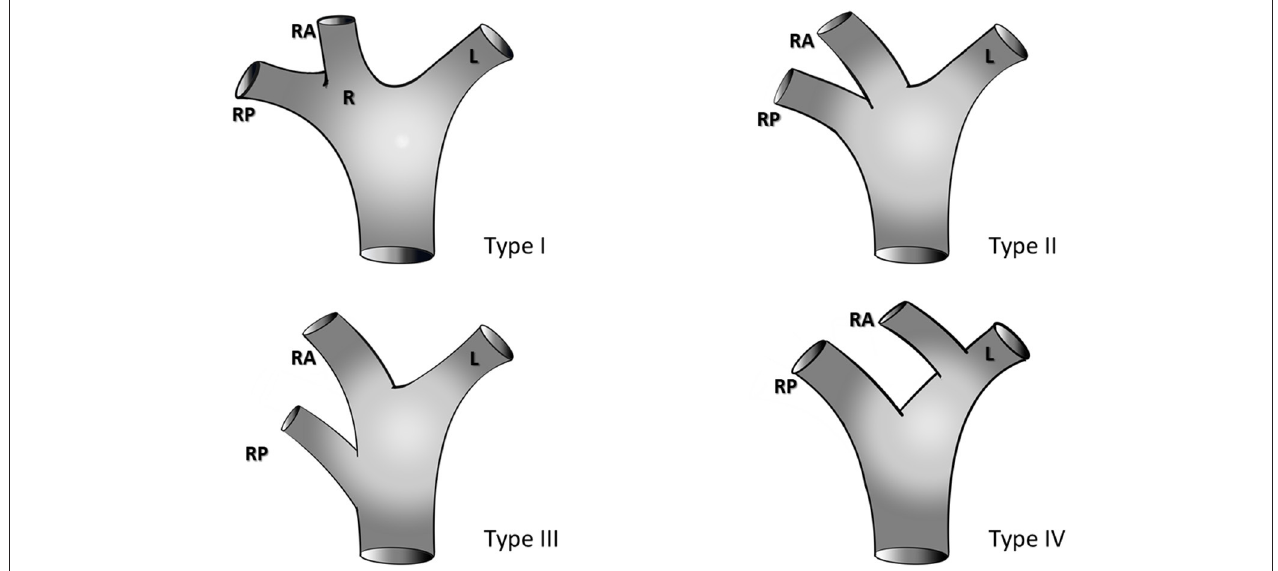
FIGURE 1 | Portal vein anatomy according to the classification of Cheng et al. (28), R, Right portal pedicle; RA, right anterior portal pedicle; RP, right posterior portal pedicle; L, left portal pedicle.